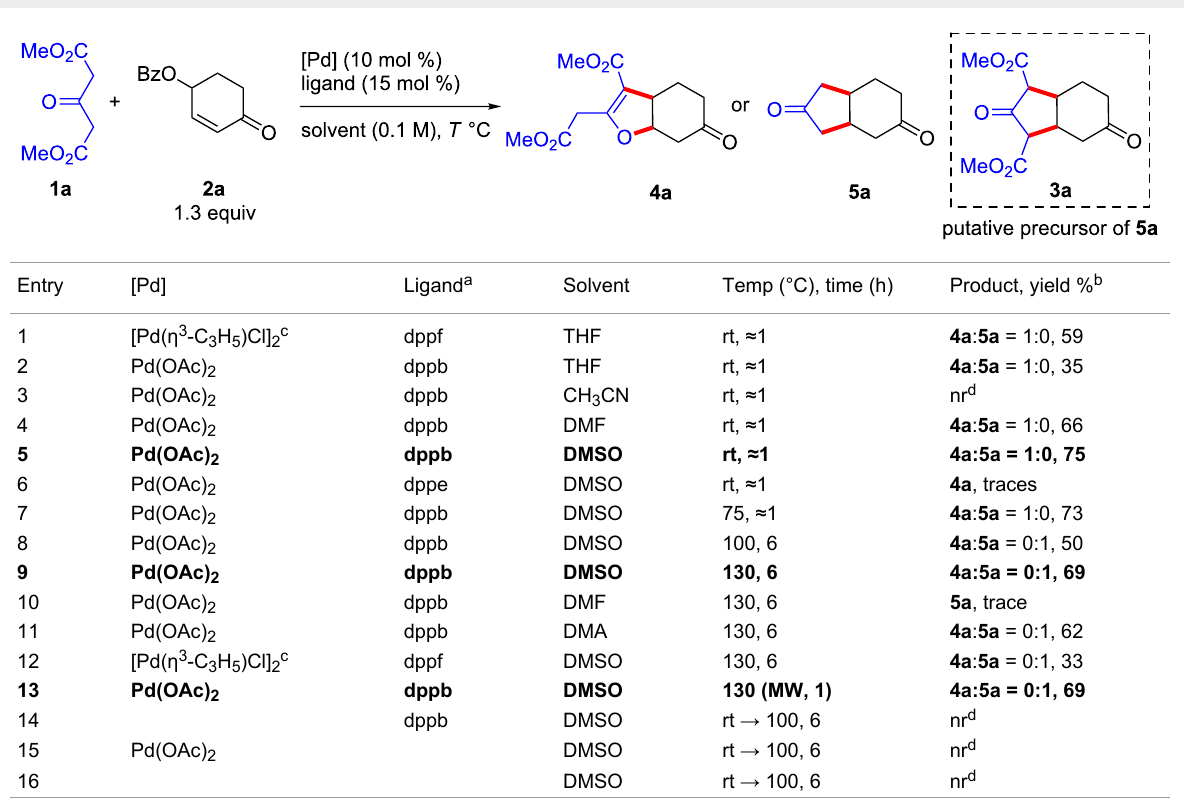
Table 1: Optimization of the reaction